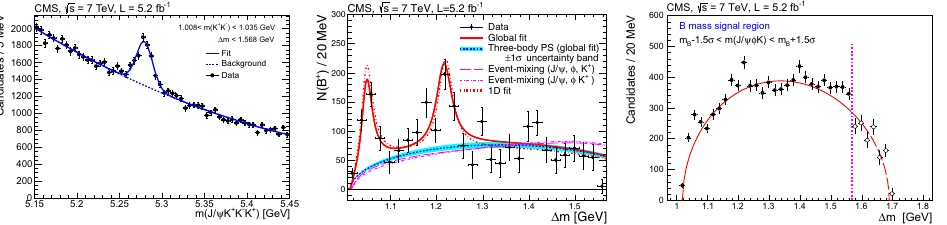
Figure 2. The J /ψφ K ± mass distribution with the standard event selection (left). The number of J /ψφ K ± candi- dates as a function of Δ m = m ( μ + μ − K + K − ) − m ( μ + μ − )(middle). The Δ m spectrum, including non-B candidates after subtracting B 0 s contribution, within ± 1.5 σ of the B nominal mass. The dashed vertical line indicates the boundary of the region eliminated from the analysis (right region). The data in the left region are represented by black markers. The entries in the right region are subtracted of the B 0 s background component and are represented by open circles. The red curve is a three-body phase-space distribution, normalized in the left region (solid) after subtracting the yields from the corresponding two structures, and extrapolated to the right region (dashed